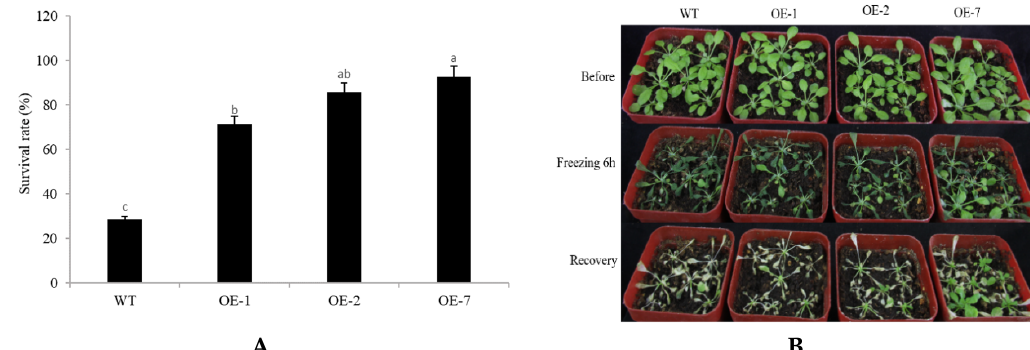
Figure 7. Overexpression of CpNAC68 confers enhanced tolerance to salt stress in transgenic Ara- bidopsis. ( A ) Performance of OE lines and WT plants after salt stress for 10 days, followed by recov- ery at normal conditions for 4 days. Images were taken at the indicated time points. ( B ) SPAD value of OE lines and WT plants under salt treatment. ( C ) Electrolyte leakage of OE lines and WT plants under salt treatment. ( D ) MDA content of OE lines and WT plants under salt treatment. Values represent the averages of three independent repeated trials. Data represent the mean ± SE. Bars correspond to the standard error. The significance test was performed by Duncan’s multiple range test, which is indicated by different letters.